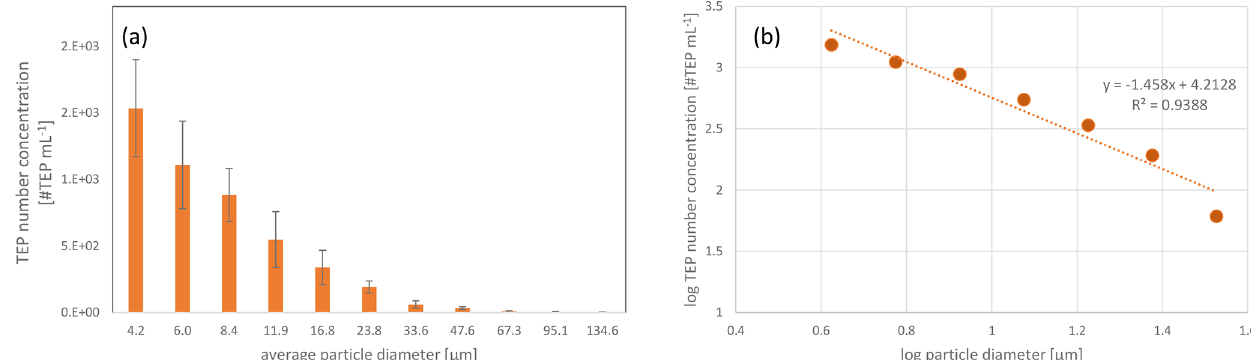
Figure 5. Transparent exopolymer particle (TEP) number size distributions in the ocean surface water (sampling depth: 10m) from the East Tropical North Atlantic (ETNA), averaged three stations from Engel et al. (2020). The data in this figure show the size distribution between ∼ 5 and ∼ 30µm, matching the investigated aerosol size range (Fig. 4). The whole size spectrum is shown in Table S5.